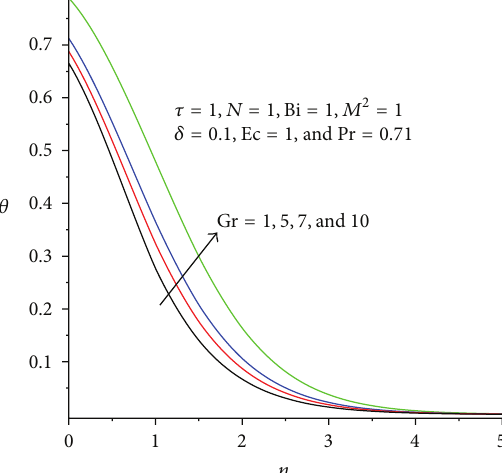
Figure 14: Temperature profiles with increasing Bi.